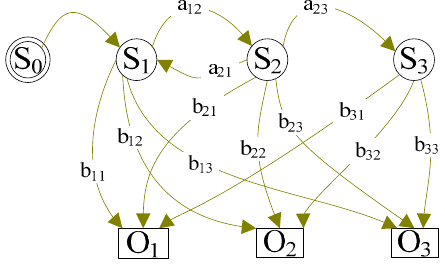
Figure 1. Hidden Markov Model (HMM) with its five parameters.